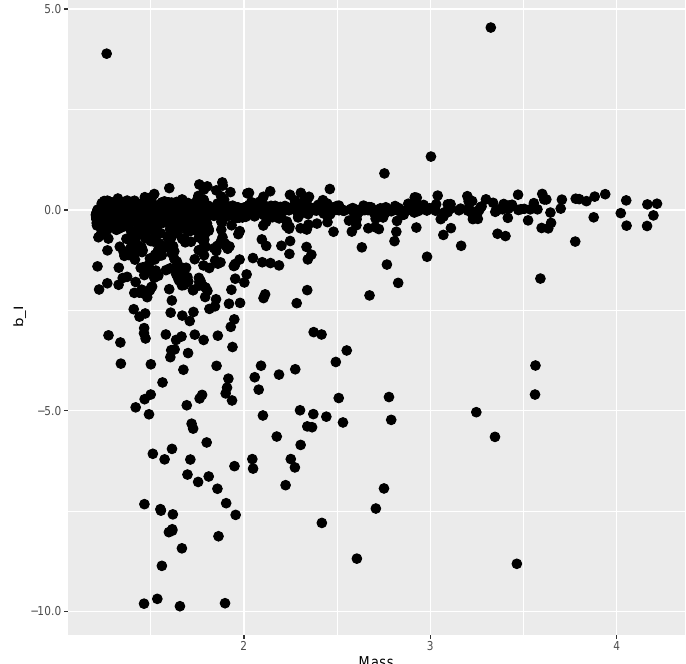
Figure 3. Mass and b I of sample points.